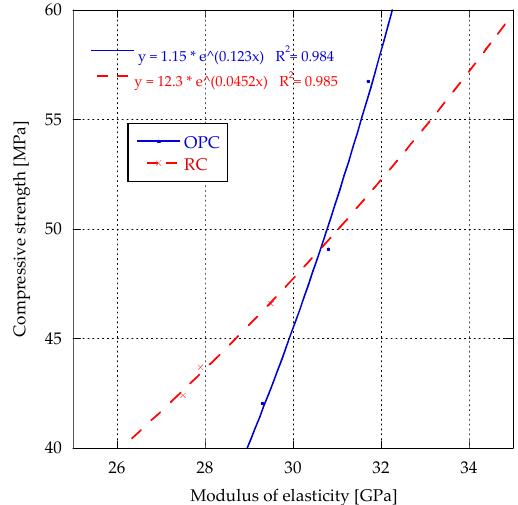
Figure 7. Compressive strength vs. modulus of elasticity.